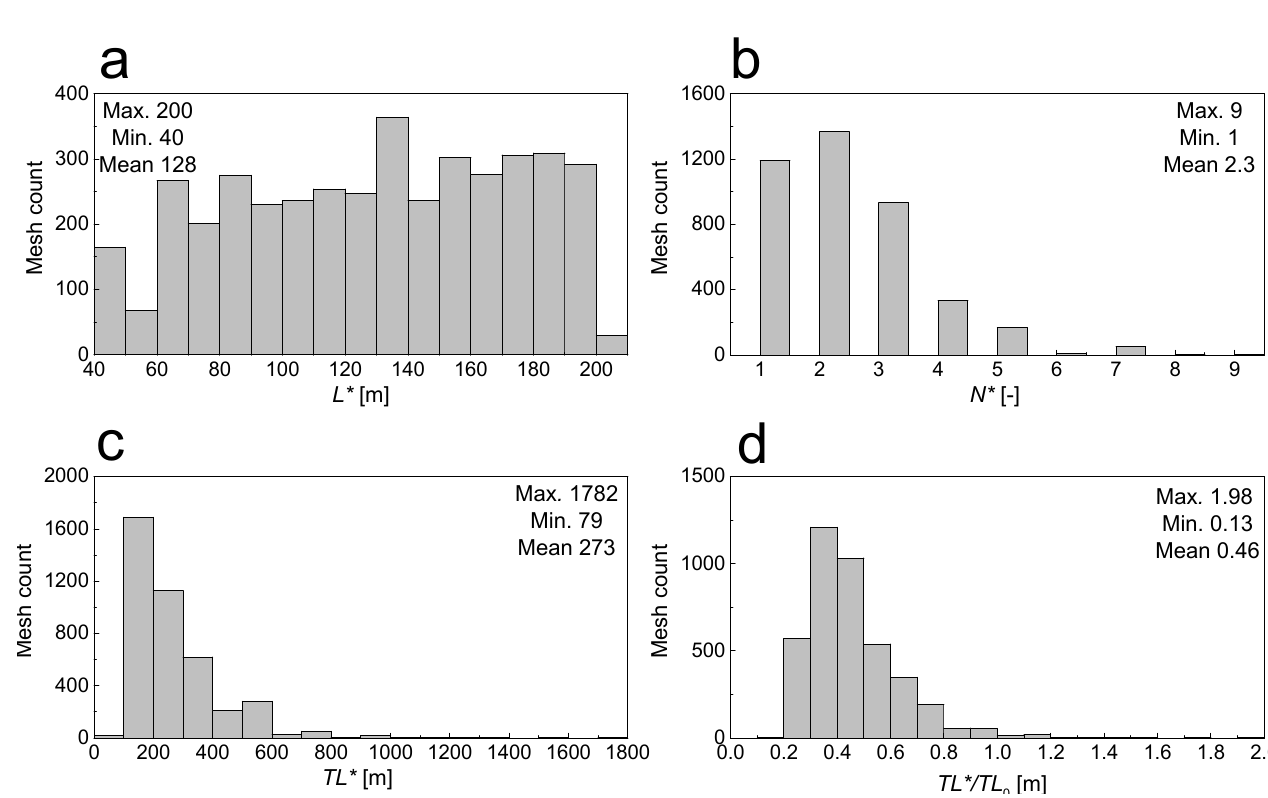
Figure 6. Simulation results of required length of each BHE L * ( a ), total number of BHEs N * ( b ), total length TL * ( c ), and the reduction ratio compared with conventional total length TL */ TL 0 ( d ).